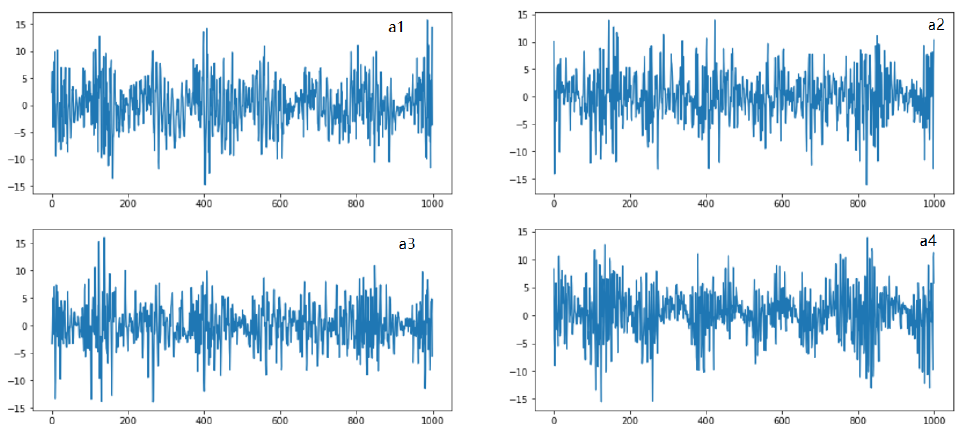
Figure 3. Time-domain analysis of each individual sensor e.g., a 1 , a 2 , a 3 , a 4 .